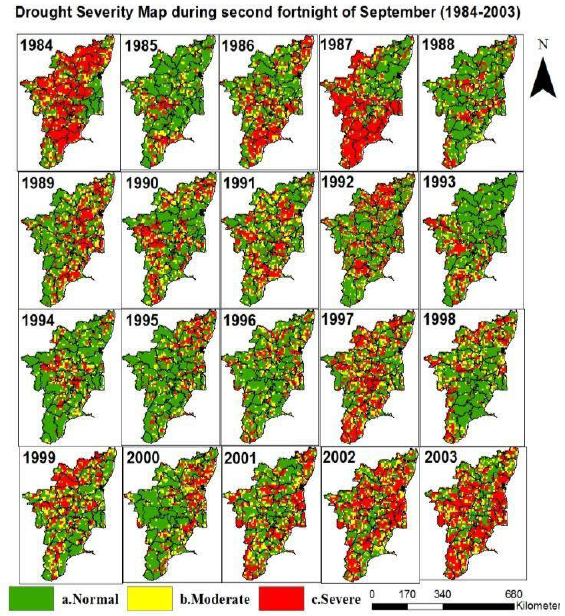
Figure 9 Drought intensity maps for 20 years during nd September 2